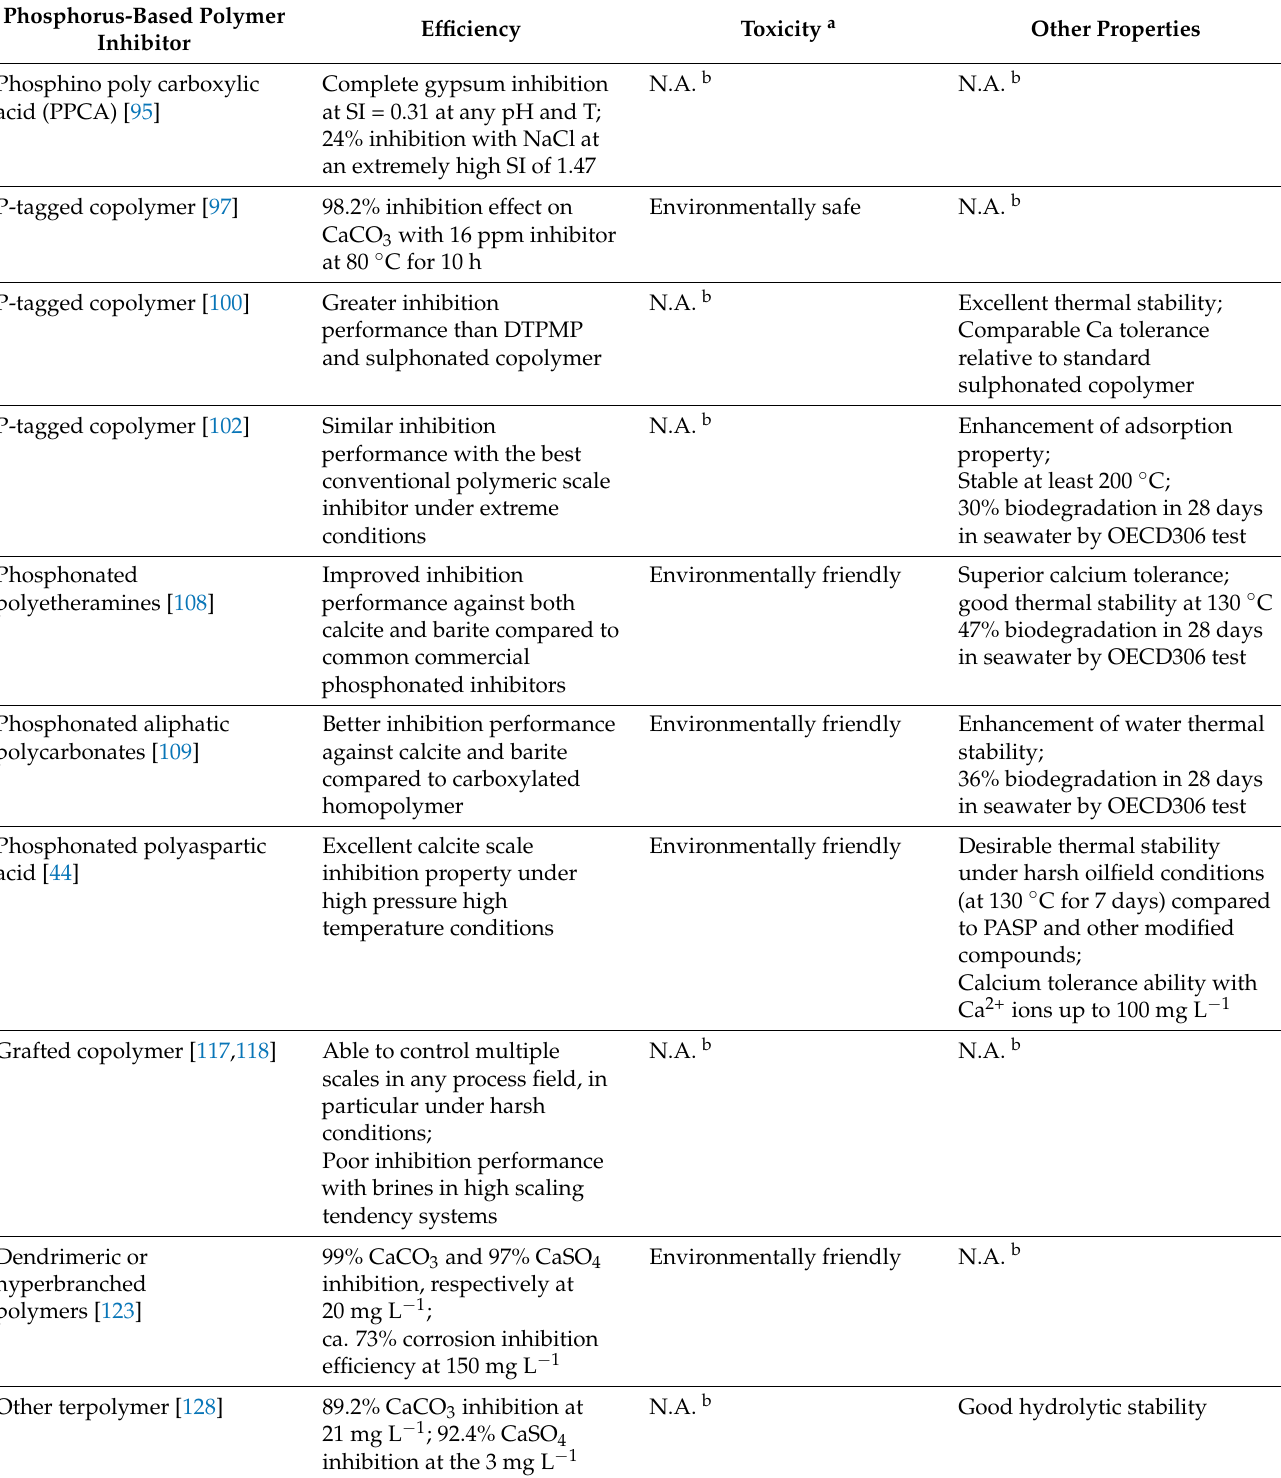
Table 4. Properties of recently developed phosphorus-based